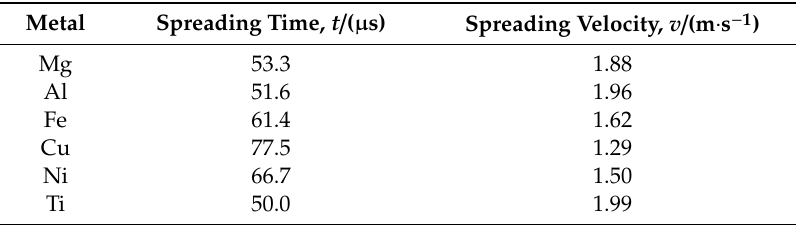
Table 4. The estimated spreading characteristics of melt